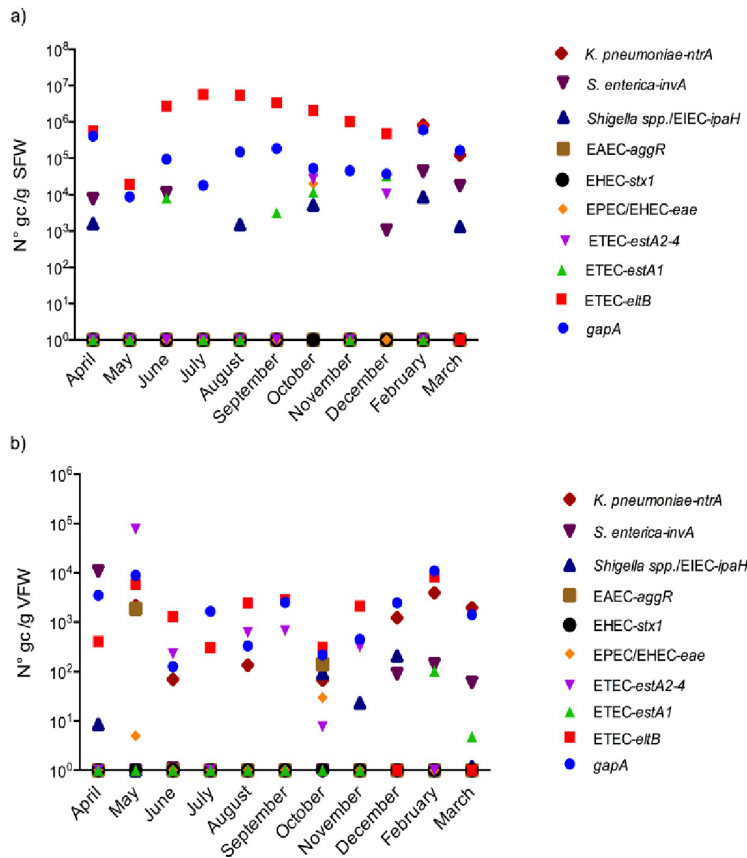
Fig 3. Number of pathogen gene copies in samples from the agricultural area Mecapaca (SP3) during the year of sampling (2013–14) obtained by qPCR absolute quantification analysis. a) soil samples and b) vegetables (lettuce and chard). Results are expressed in number of genes copies per gram of soil fresh weight (N˚ gc/g SFW) or vegetable fresh weight (N˚ gc/g VFW). Number of gene copies is expressed in logarithmic scale; only values greater than zero are plotted. Samples from January 2014 were not included in this